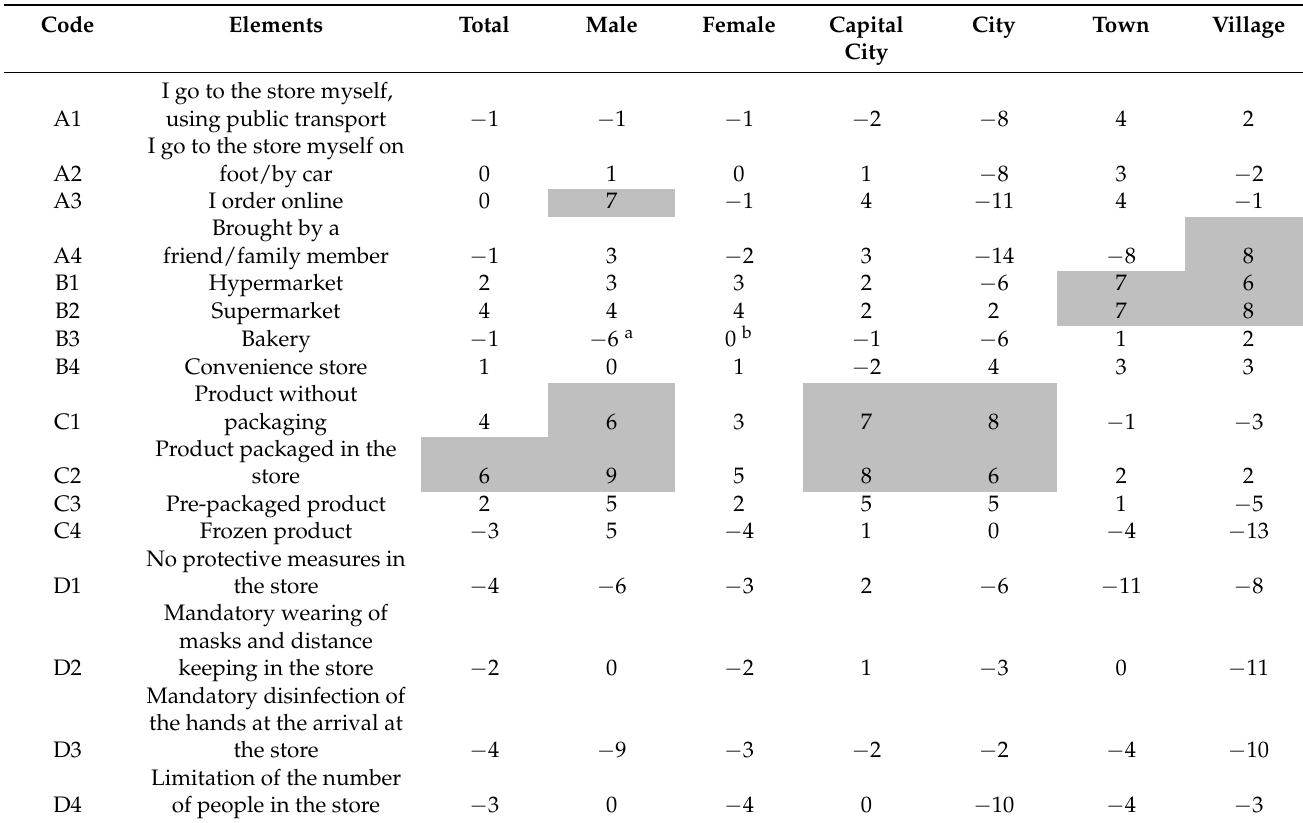
Table 3. Regression coefficients for models relating the presence/absence of the elements to the rating of safety, after binary transformation. The highest coefficients of each group are colored as gray. High positive coefficients denote a strong feeling of safety, while low negative coefficients mean the opposite. Coefficients around 0 mean neutral feelings. Superscript letters denote the homogenous subsets defined by Tukey post hoc test ( p <